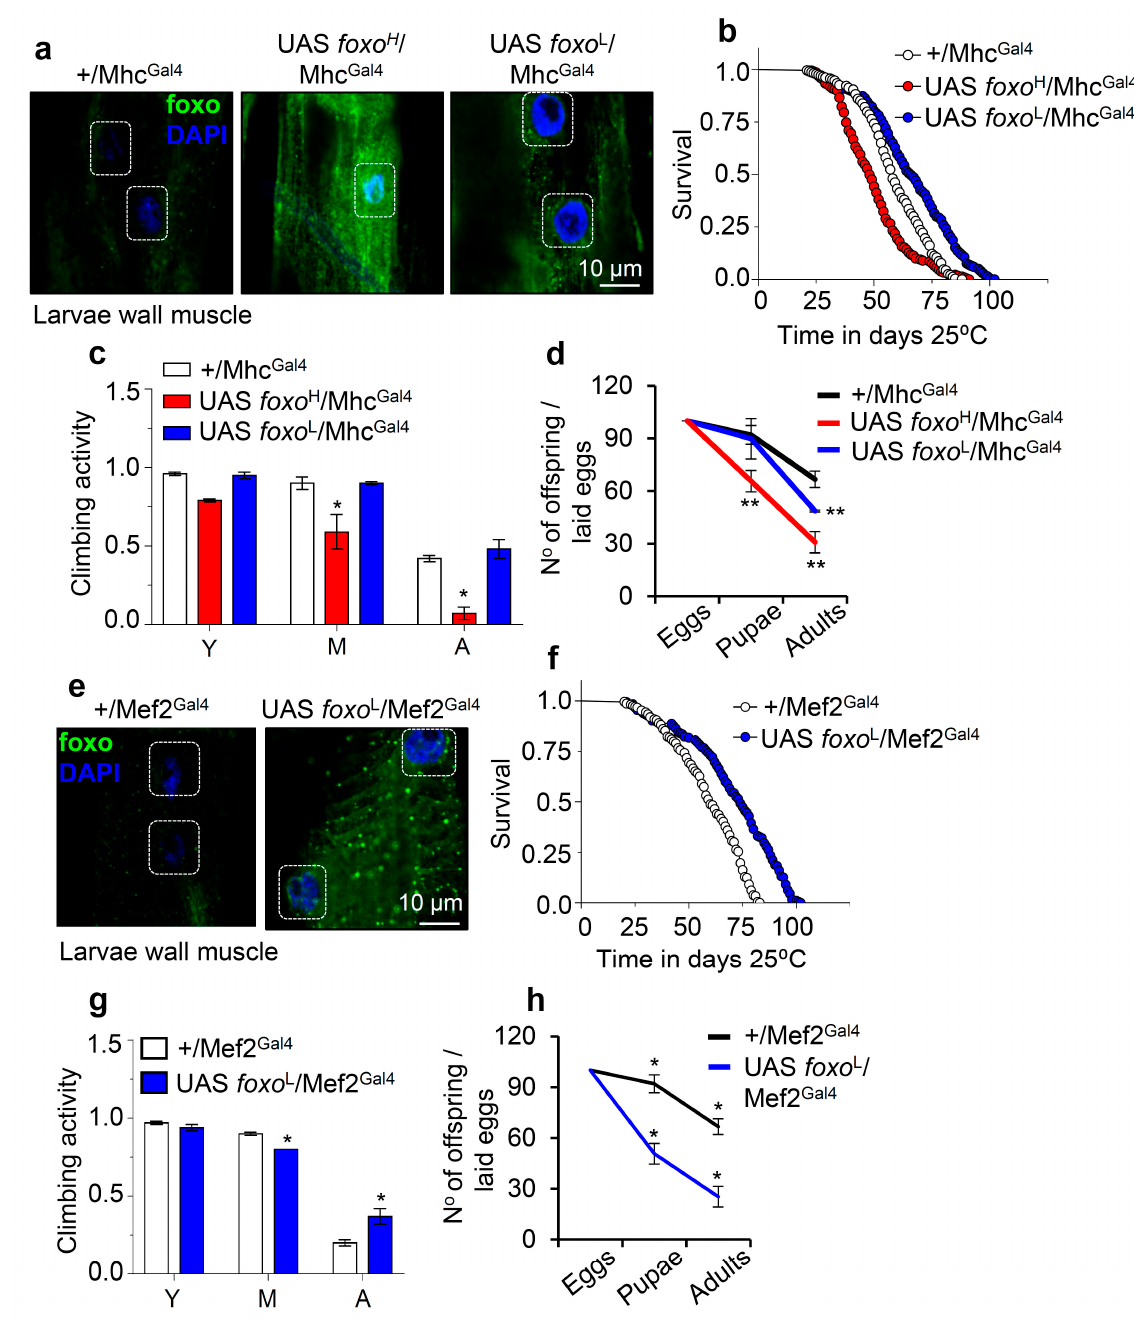
Figure 4. Muscle-targeted foxo OE delays aging dose-dependently. ( a ) Representative CLSM images of third instar larvae body wall’s muscle fibers after targeted foxo OE in muscles (Mhc Gal4 ); samples were stained with an anti-FOXO antibody and counterstained with DAPI. ( b – d ) Longevity ( b ), locomotion performance (climbing activity) of young (Y), middle-aged (M), and aged (A) flies ( c ), and offspring number per laid eggs ( d ), of Drosophila flies with the shown genotypes vs. respective controls. ( e ) Representative CLSM images of third instar larvae body wall’s muscle fibers after muscle targeted (Mef2 Gal4 ; driver with strong expression) OE of foxo L ; samples were stained with an anti-FOXO antibody and counterstained with DAPI. ( f – h ) Lifespan ( f ), locomotion performance (climbing activity) at indicated ages ( g ), and offspring number per laid eggs ( h ) of the shown transgenic flies. Statistics of longevity assays are reported in Table S1. Bars, ± SD; n ≥ 3, ≥ 10 flies were analyzed per experimental repeat. In ( c , d , g , h ) significant differences were calculated with the unpaired t -test, * p < 0.05, ** p <